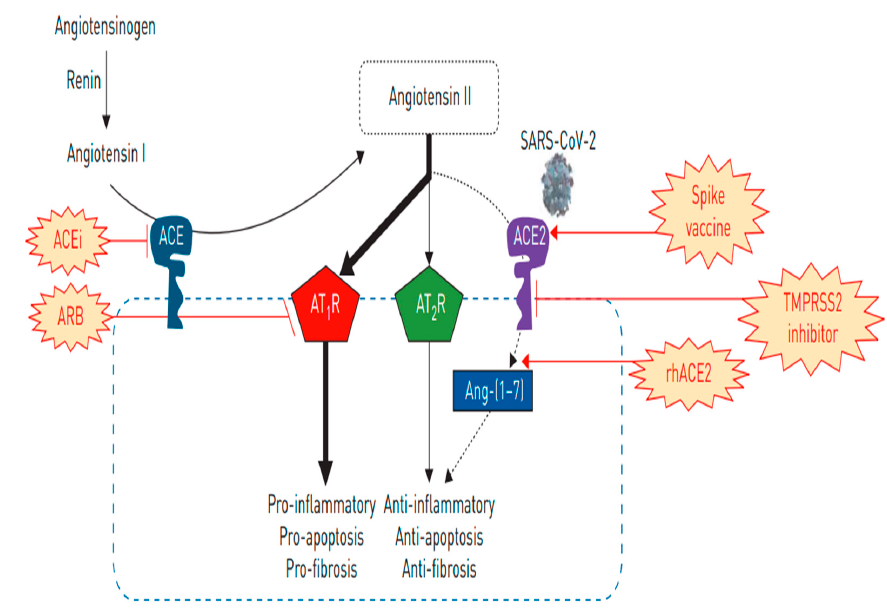
Figure 5. The RAAS with COVID-19. The thicker arrows show an increase in the degree of path- way activation; dotted arrows show a decrease in pathway activation. ACE: angiotensin-convert- ing enzyme; ACE-2 : angiotensin-converting enzyme-2; AT1R: angiotensin type 1 receptor; AT2R: angiotensin type2 receptor; ANG 1–7: angiotensin 1–7; ARB: angiotensin receptor blockers; rh ACE-2 : recombinant human ACE-2 ; TMPRSS2: transmembrane serine protease 2 (figure replicated from [46] with permission).